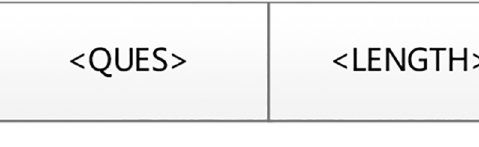
Fig 3. Protocol format analysis